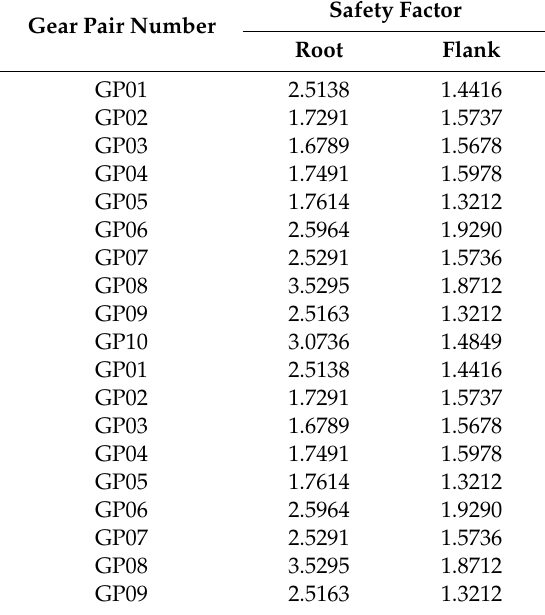
Table A2. List and description of test rig